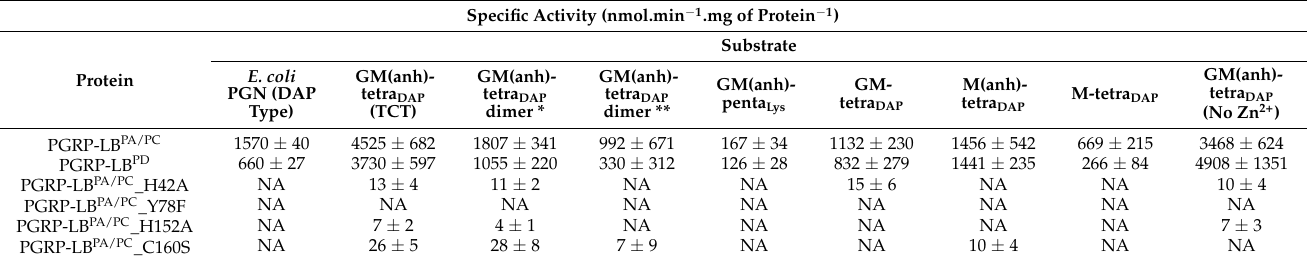
Table 1. In vitro enzymatic activity of Drosophila PGRP-LB isoforms and their mutants toward different substrates. Specific Activity (nmol.min − 1 .mg of Protein − 1 ) Protein